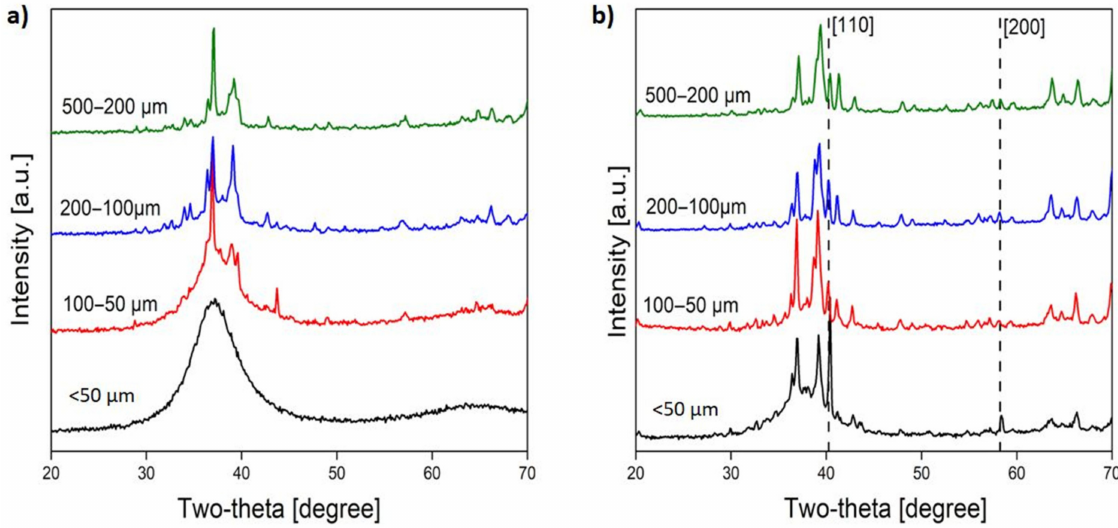
Figure 6. X-ray diffractogram for ( a ) AMZ4 and ( b ) AMZ4 +